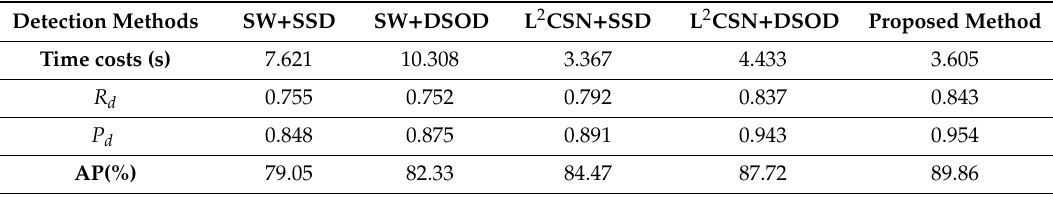
Table 1. Quantitative results with different detection methods (IoU = 0.4, Score = 0.5).